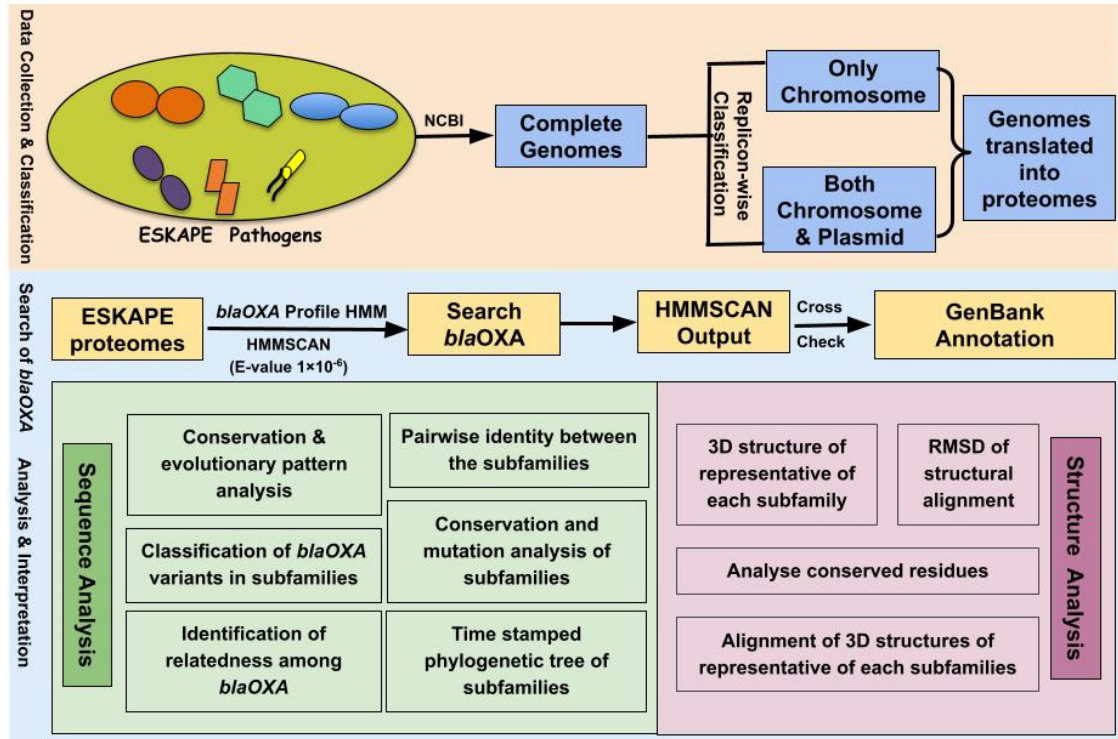
Figure 5. The overall workflow depicting the methodology used for investigating the OXA variants of ESKAPE pathogens.